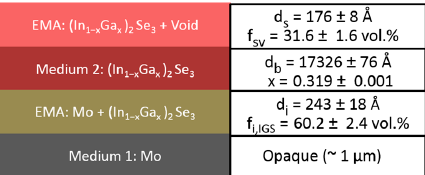
Figure 8. Schematic of the structural model with best fit parameters and confidence limits obtained in the analysis of the data in Figure 7. The parametric expression for the ( ε 1 , ε 2 ) spectra of IGS at 400 °C defined in Table 2 is used for the determination of the IGS composition. The roughness and interface contents f sv and f i,IGS represent the void and IGS component of the EMA layers, respectively.